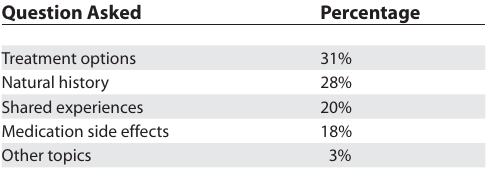
Table 1. BrainTalk Communities Online Epilepsy Support Group: Types of Questions Asked by